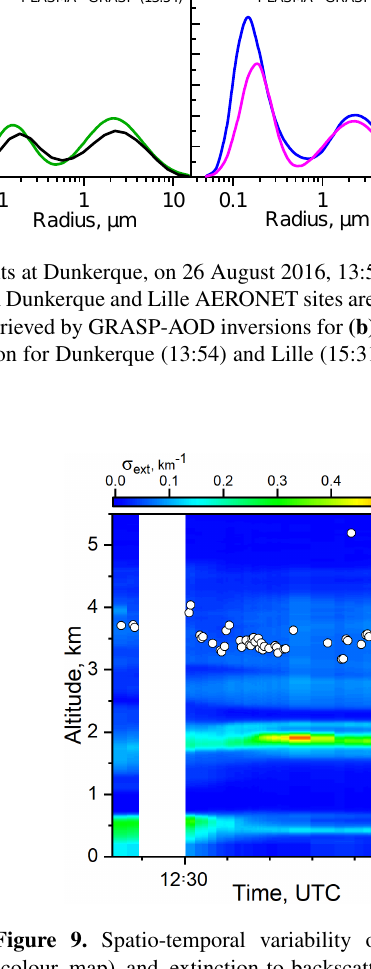
Lille, while values of 0.05 and 0.14 km − 1 for mean and max- imum extinction are found along the second half of the road.